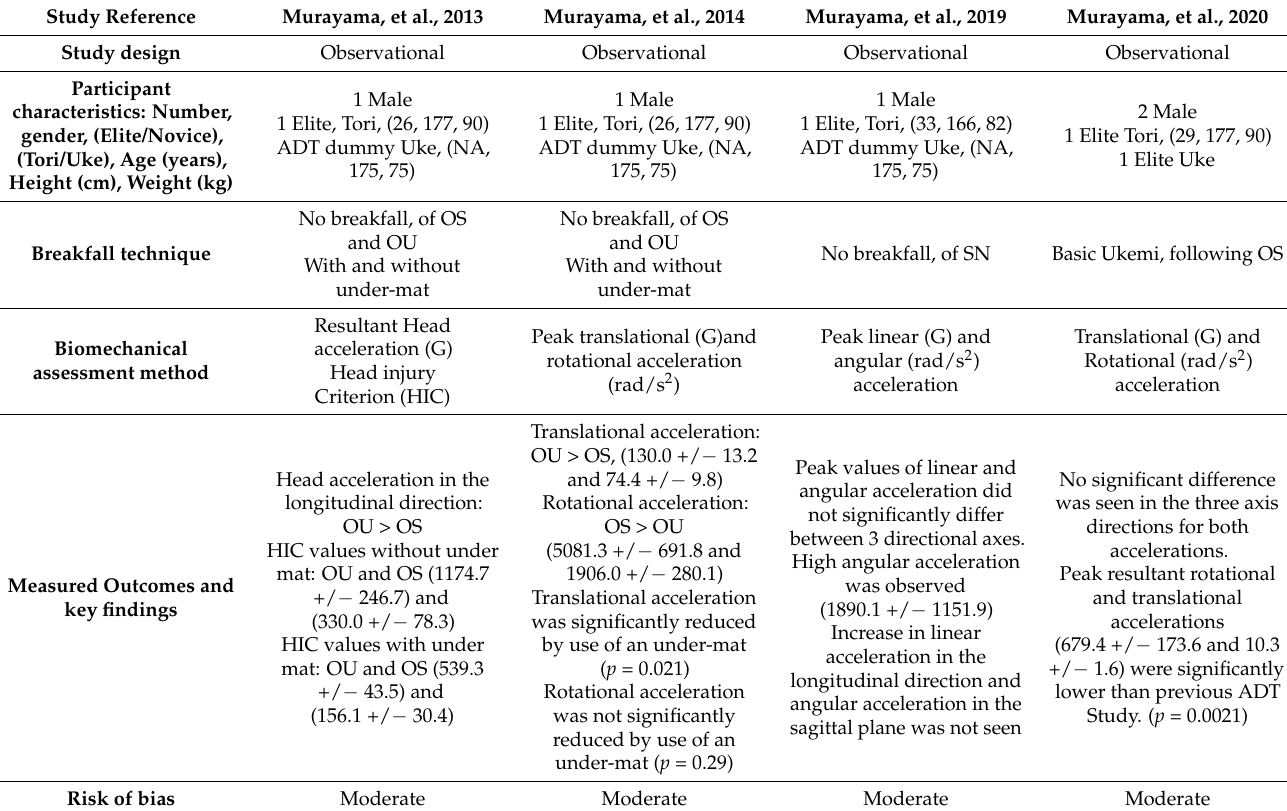
Table 5. Study characteristics and